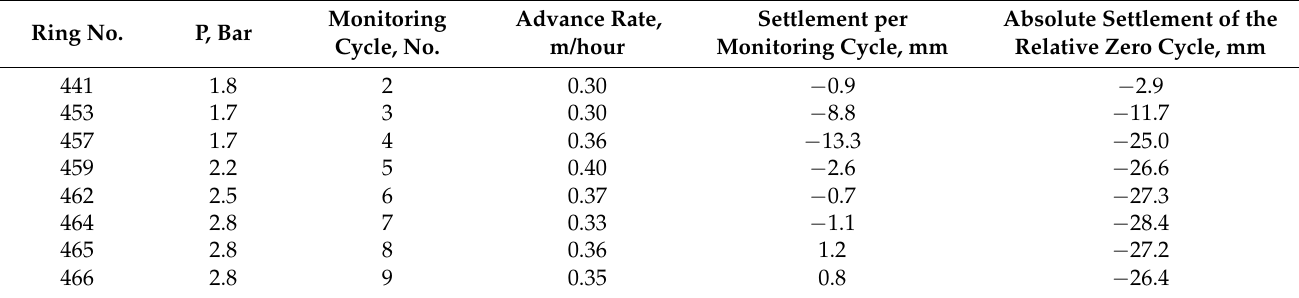
Table 2. Monitoring data and tunneling